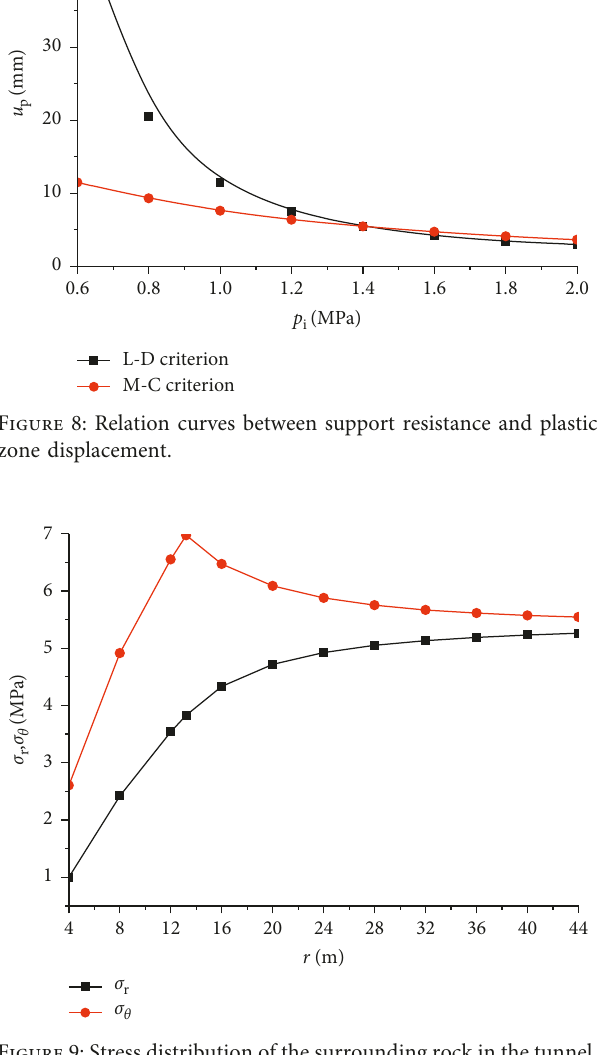
Figure 9: Stress distribution of the surrounding rock in the tunnel.